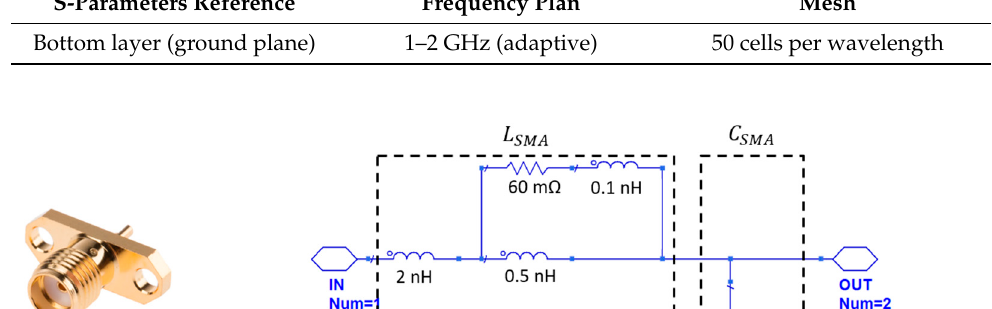
Table 1. Electromagnetic (EM) simulation setup for PCB design modeling.